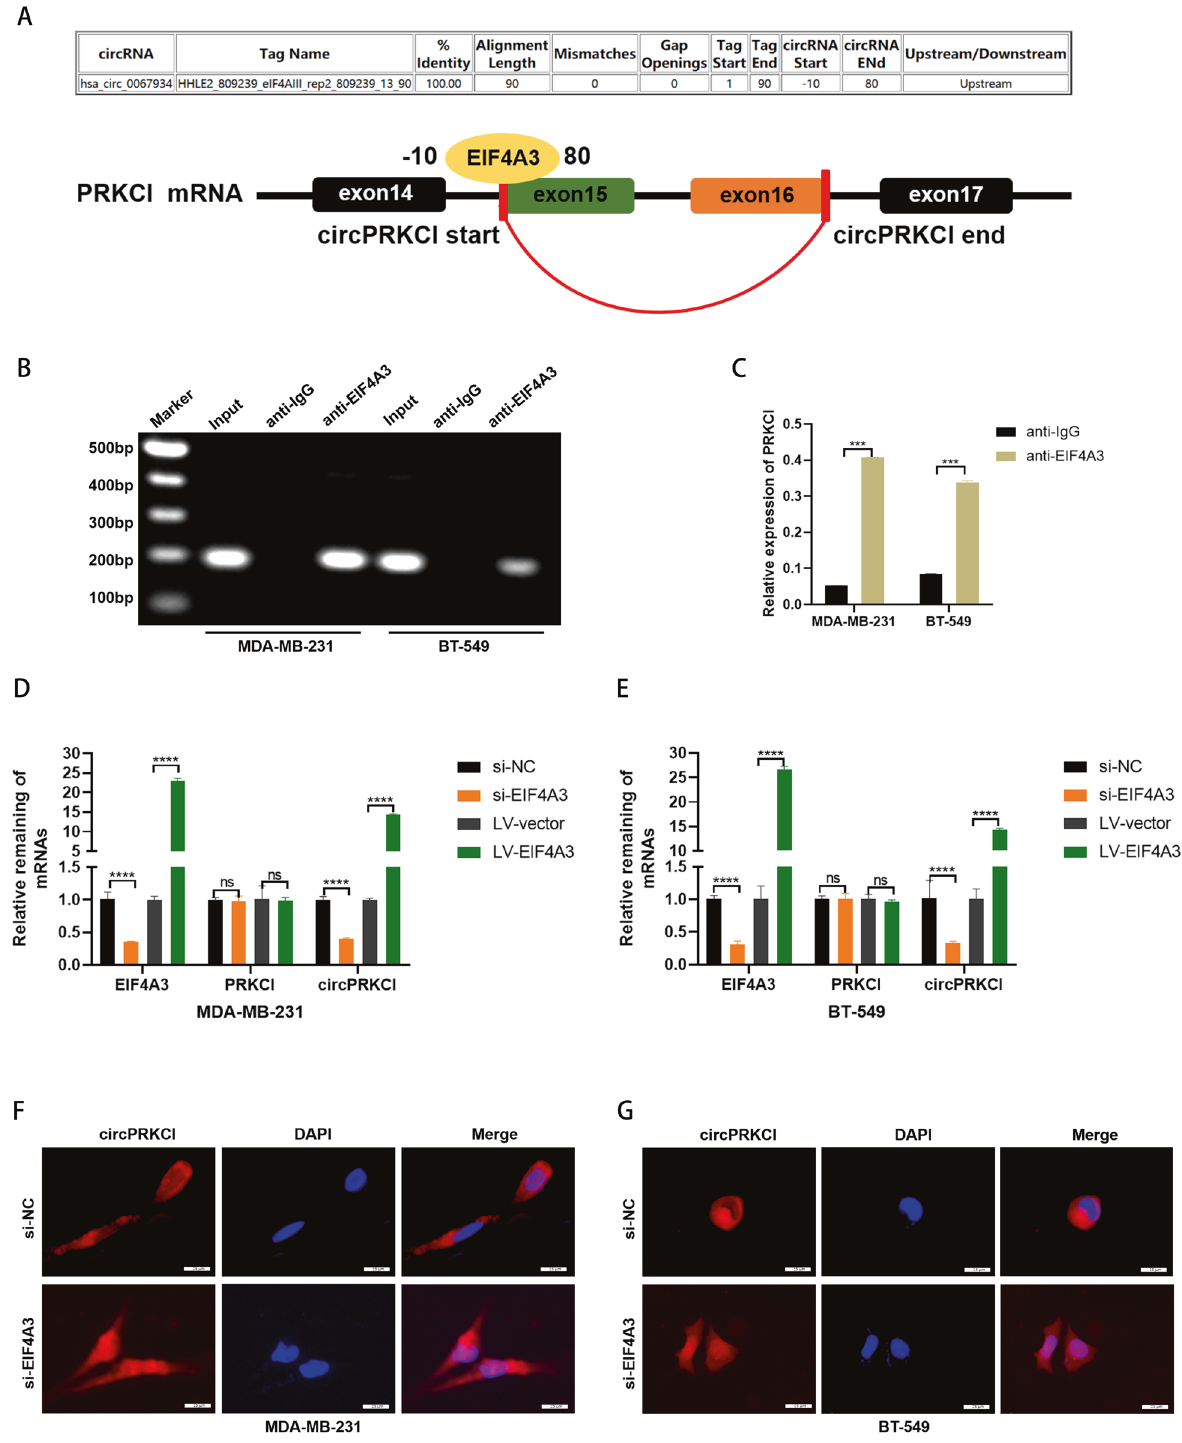
Fig. 7 EIF4A3 induced circPRKCI expression and nuclear export in TNBC cells. A The binding sites of EIF4A3 in the fl anking sequences of the PRKCI mRNA transcript were predicted. B , C RIP assay was applied to validate the binding of EIF4A3 to PRKCI mRNA. D and E The mRNA level of circPRKCI and PRKCI were evaluated in BC cells transfected with si-EIF4A3 and LV-EIF4A3. F , G RNA FISH for circPRKCI and nuclei was stained with DAPI in BC cells transfected with si-NC or si-EIF4A3. Red, circPRKCI; Blue,